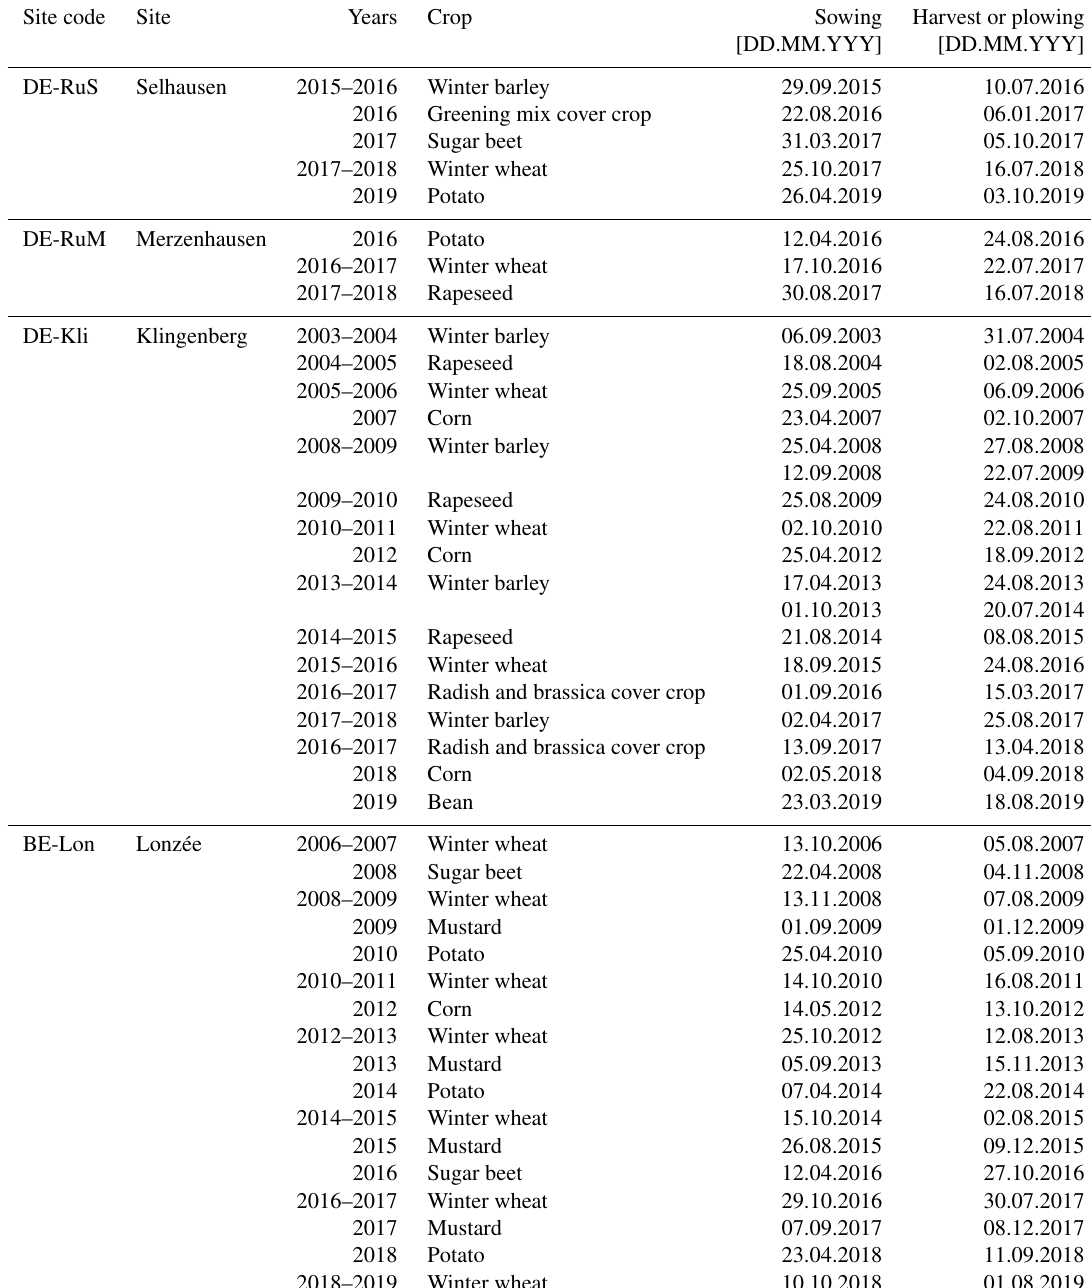
Table A1. Sowing and harvest dates at the ICOS and TERENO cropland study